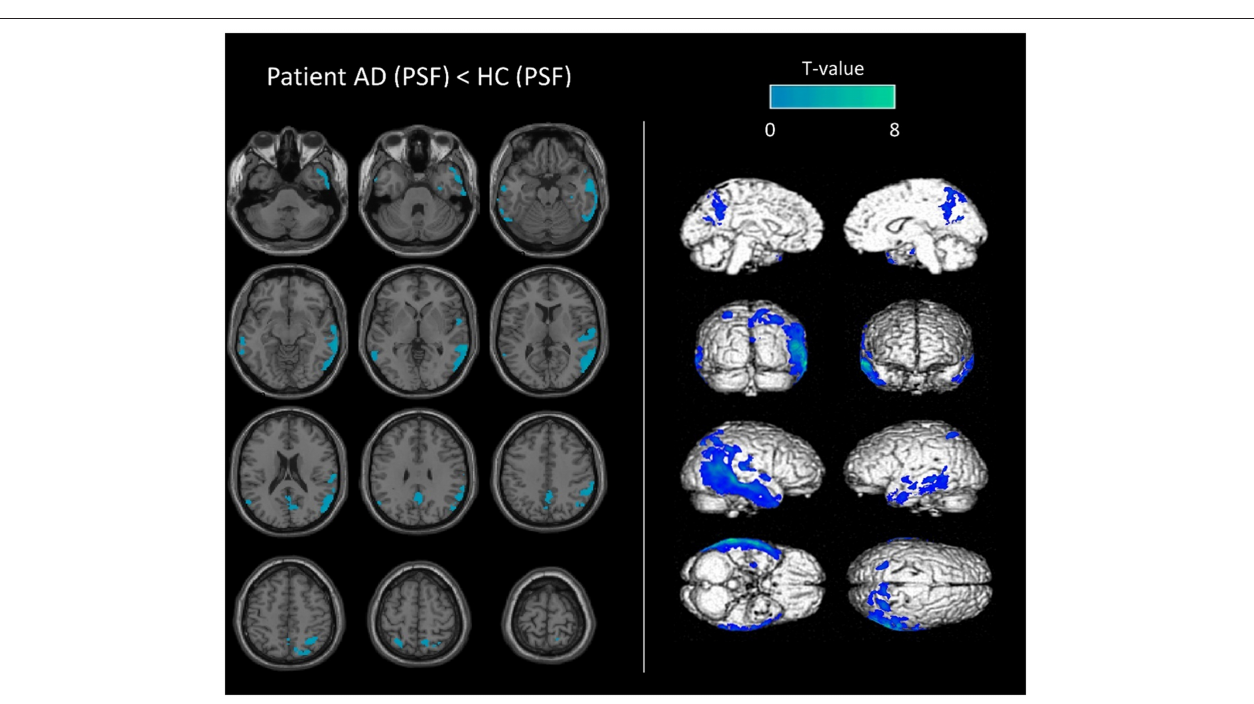
FIGURE 3 | Representative SPM-T map images used in the visual analysis. Anatomical localization of decreased metabolic activity in an AD patient (79-year-old man with MMSE score of 10), compared to controls. SPM-T maps are projected onto two-dimensional slices of T1-weighted MRIs (from the base to the top of the skull, left panel) and 3D-rendered volumes (right panel). Images used in this example (AD patient and controls group) were reconstructed using PSF deconvolution.